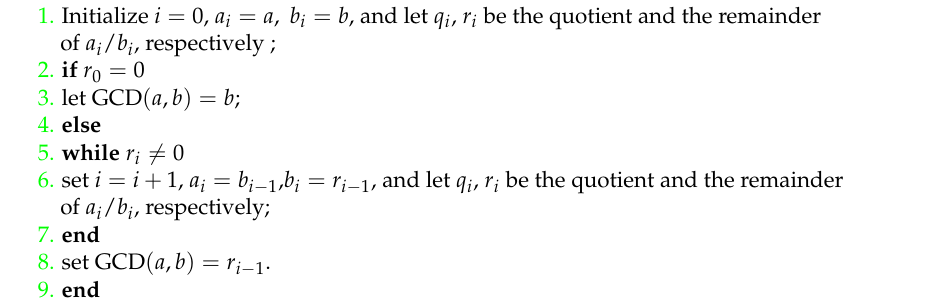
Table 2. Pseudocode of the Euclidean algorithm (repeated